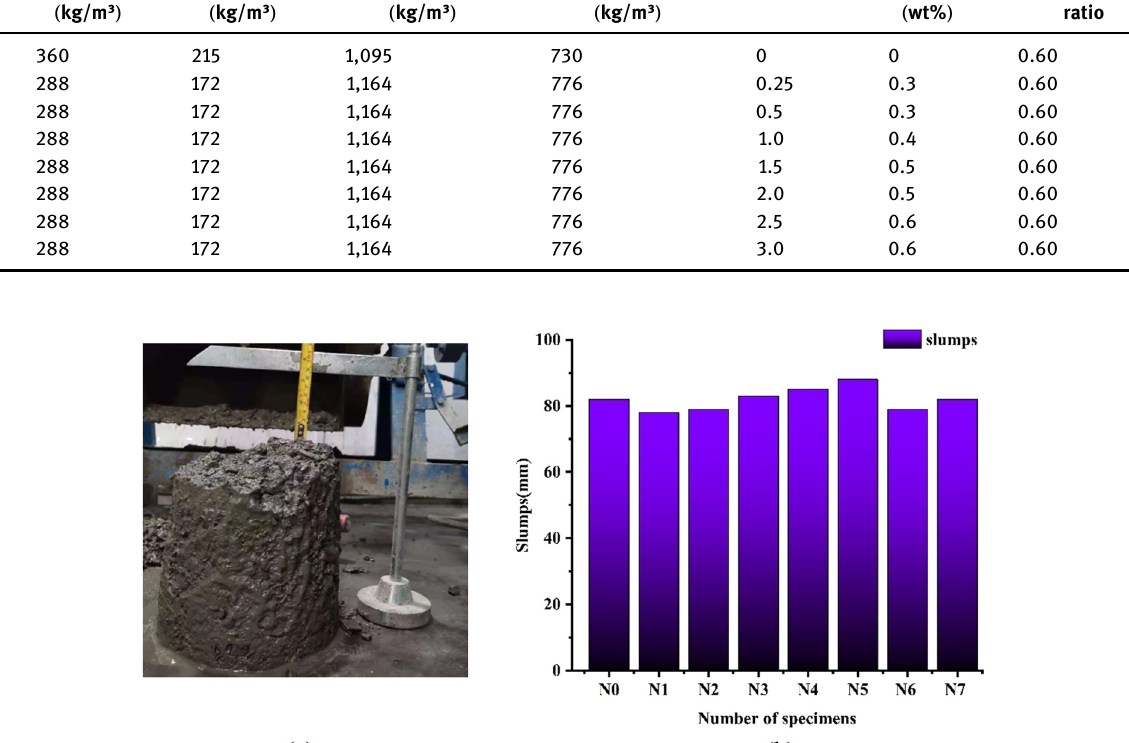
Table 9: Proportioning of concrete Cement ( kg/m³ )